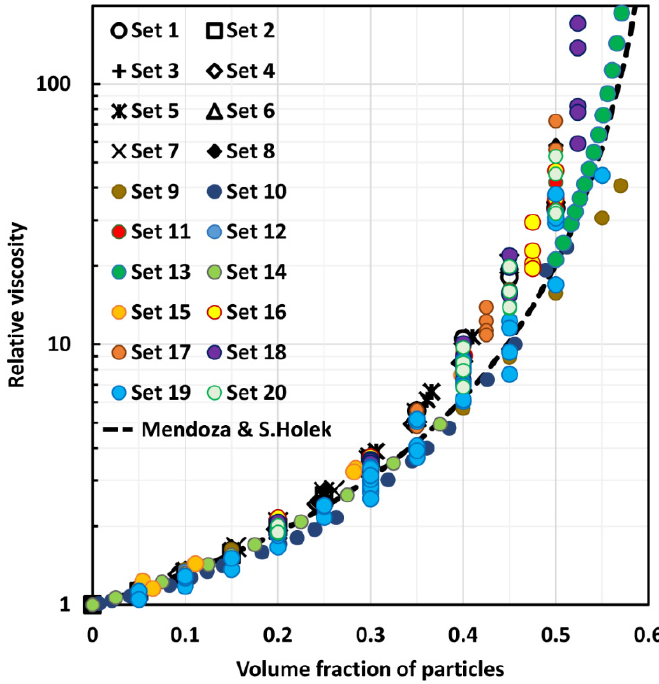
Figure 11. Comparison of experimental viscosity data for suspensions of non-Brownian hard spheres with the predictions of model proposed by Mendoza and Santamaria-Holek ( φ m = 0.637 ).